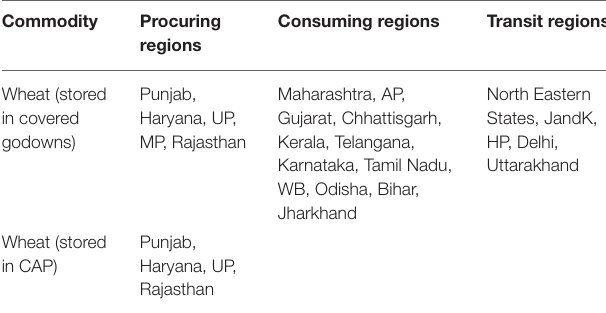
TABLE 1 | Consuming, procuring, and transit regions defined by the